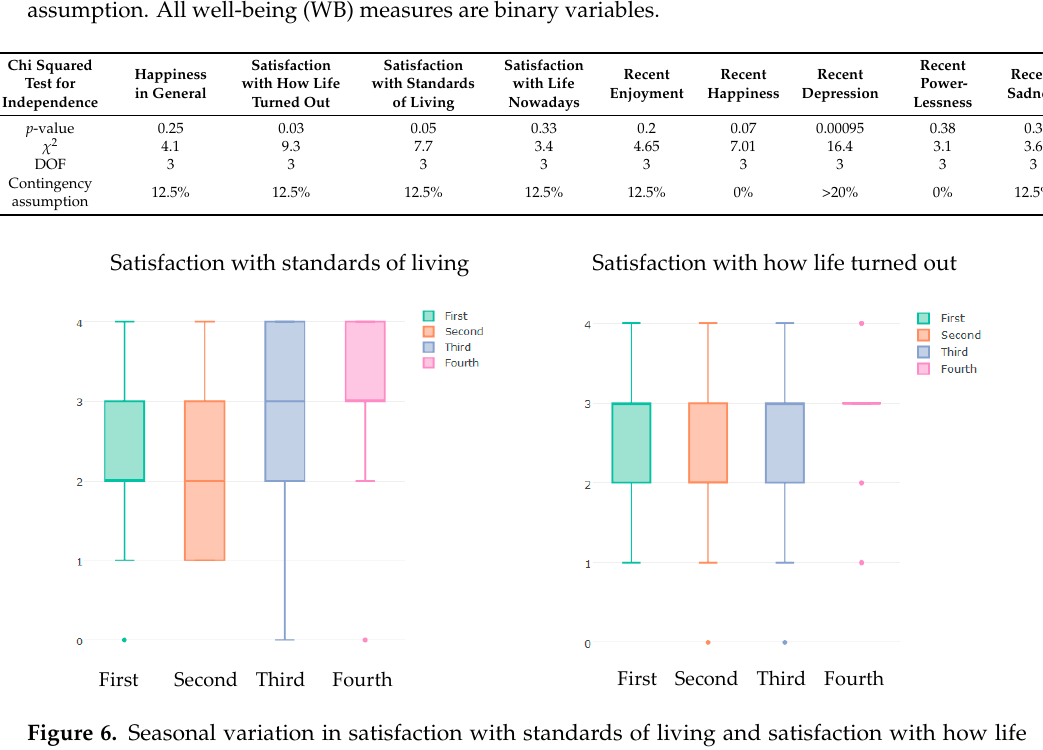
Figure 6. Seasonal variation in satisfaction with standards of living and satisfaction with how life turned out in five communities in Colorado. For both measures, a score of 4 indicates the highest level of satisfaction and a score of 0 indicates the lowest level of satisfaction. X -axis in both blots represents seasonal quarters of the year.